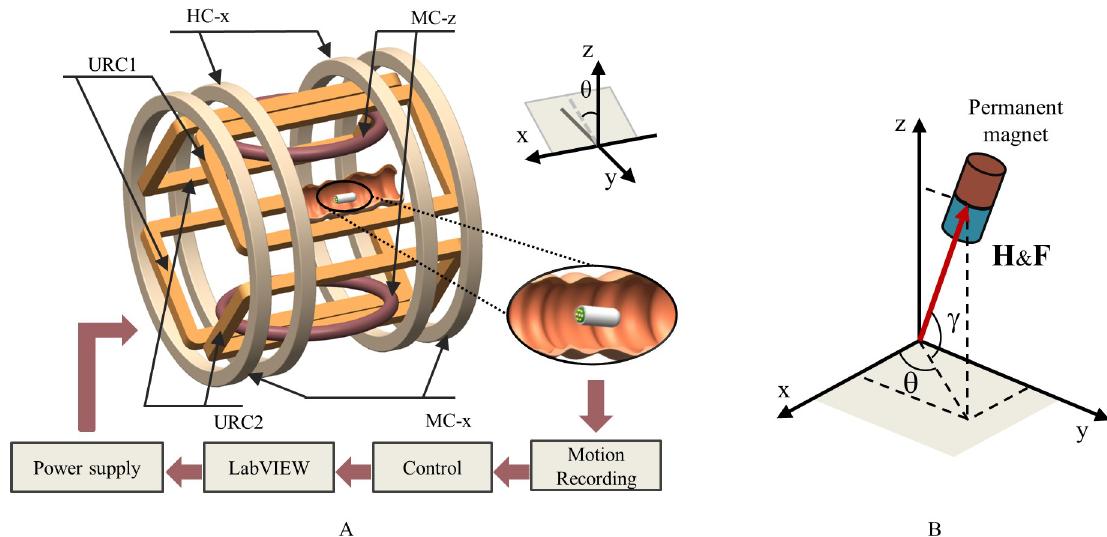
Fig 6. EMA system for capsule manipulation. (A) Configuration and control scheme of the EMA system. (B) Actuation mechanism of the TCE; the arrow indicates the generated magnetic field vector H and force vector